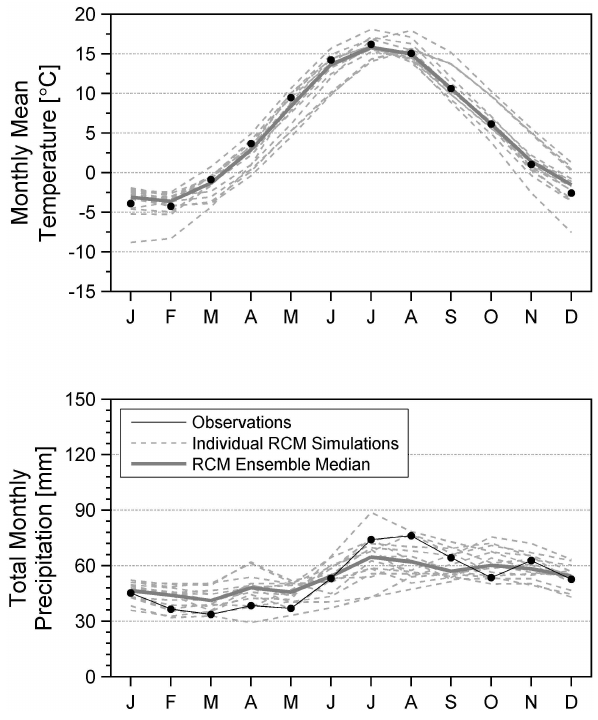
Fig. 1. Monthly mean temperature (top) and total monthly precipita- tion (bottom) for the period 1961–2000 as simulated by 15 individ- ual ERA40-driven RCMs (gray dashed lines) for the Vattholmaån catchment in southeastern Sweden. Observations (black circles) and the RCM-ensemble medians (gray continuous line) are displayed as